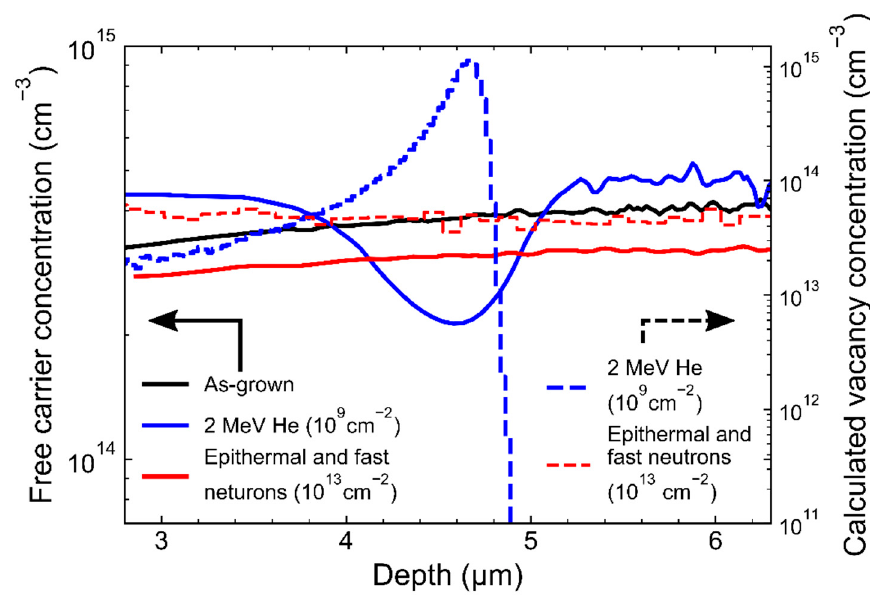
Figure 2. Free-carrier concentration profiles of as-grown, ion-implanted and neutron-irradiated n- type 4H-SiC samples (solid lines, left y axis). The calculated vacancy concentration profiles estimated for 2 MeV He ions using SRIM code (blue, dashed, right y axis) and for neutrons using FLUKA (red, dashed, right y axis). The free carrier concentration profiles are obtained from the C–V measurements.